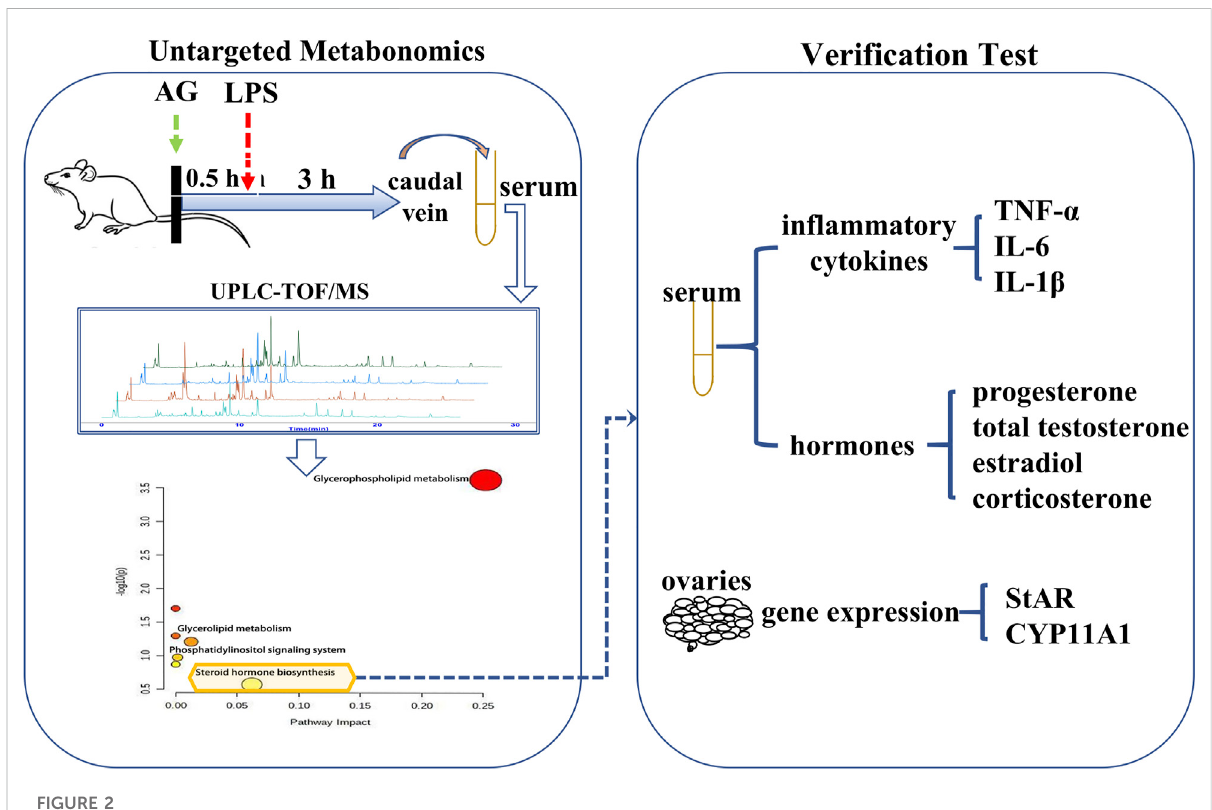
FIGURE 2 Schematic diagram of tests